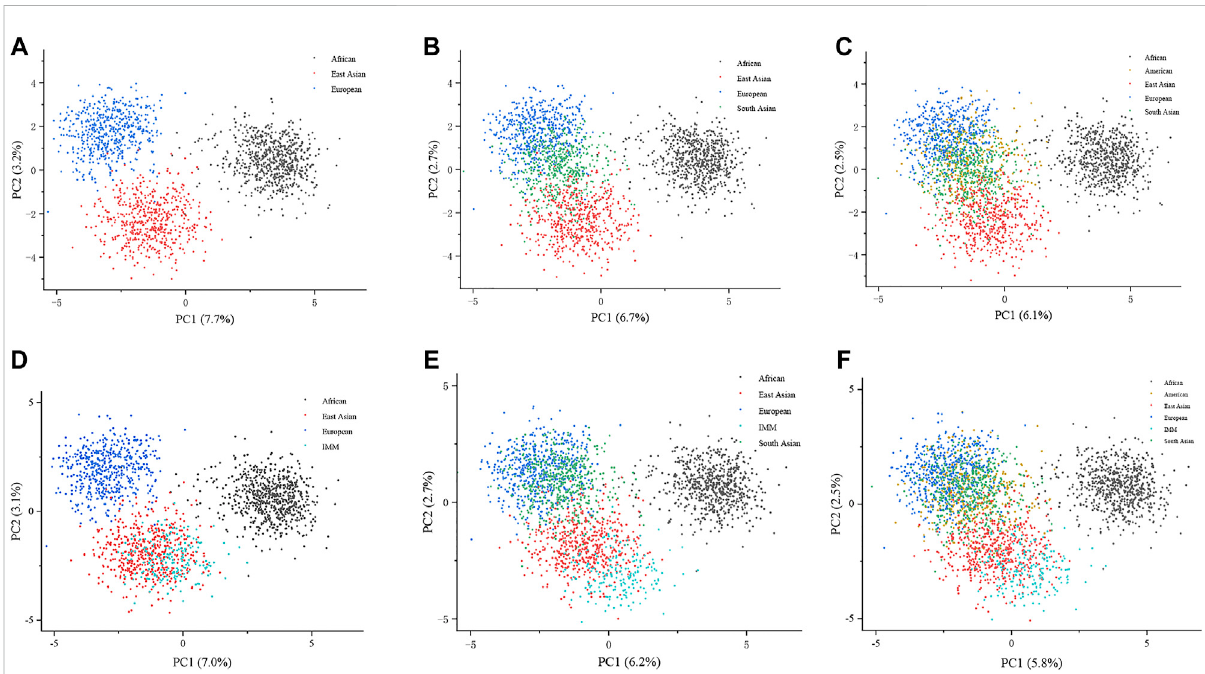
FIGURE 4 PCA plots at the individual level based on the 111 II-SNPs among the IMM group and 26 reference populations. (A) A PCA plot of African, East Asian, and European populations at the individual level based on the 111 II-SNPs. (B) A PCA plot of African, East Asian, and European populations plus IMM group at the individual level based on 111 II-SNPs. (C) A PCA plot of African, East Asian, South Asian, and European populations at the individual levelbasedonthe111II-SNPs. (D) APCAplotofAfrican,EastAsian,SouthAsian,andEuropeanpopulationsplusIMMgroupattheindividuallevel based on the 111 II-SNPs. (E) A PCA plot of African, East Asian, South Asian, American, and European populations at the individual level based on the 111II-SNPs. (F) aPCAplotofAfrican,EastAsian,SouthAsian,American,andEuropeanpopulationsplusIMMgroupattheindividuallevelbasedonthe 111